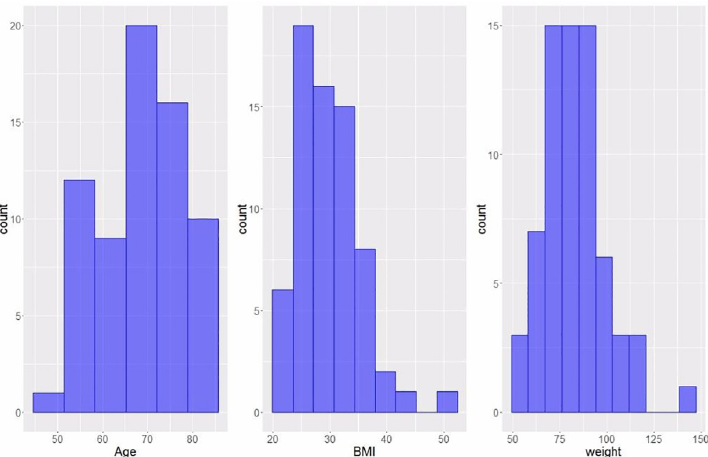
Fig 1. Distribution of age, BMI and weight profiles of participants (n = 68) with complete datasets. Within this group, 12 participants had a KL1 score, 22 had KL2, 27 had KL3 and 7 had KL4.